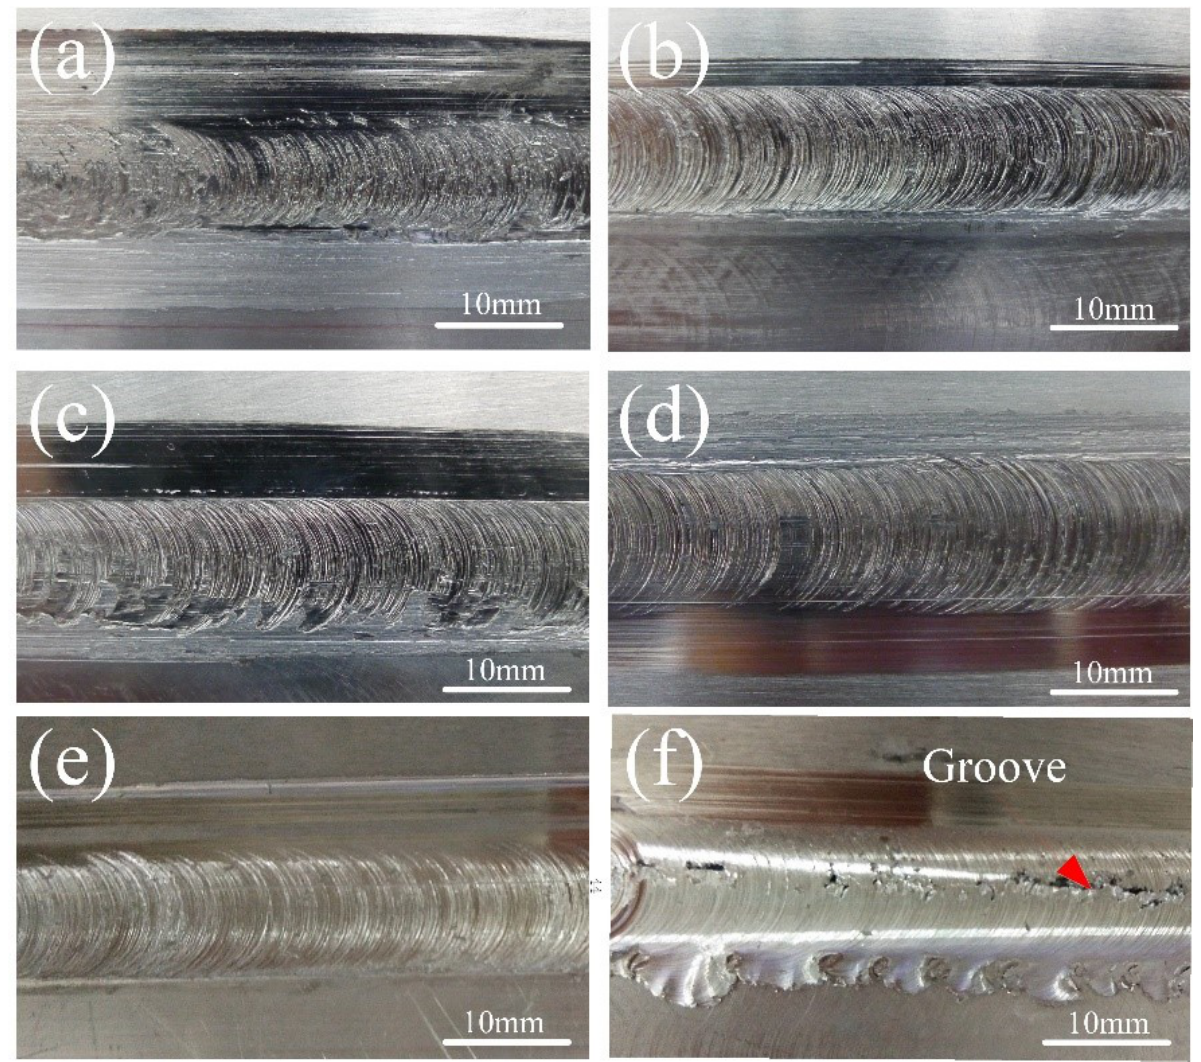
Figure 4: Surface integrity of the SSFSW joints at different welding speeds: (a) 30 mm/min, (b) 40 mm/min, (c) 50 mm/min, (d) 60 mm/min, (e) 70 mm/min and (f) 80